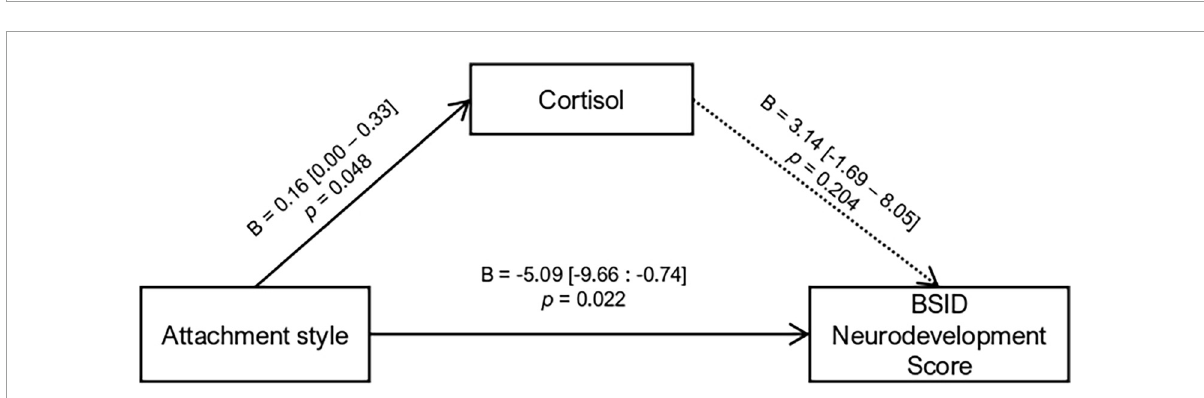
FIGURE3 Mediation analysis for Attachment Style effects on child neurodevelopment via cortisol AUC g . Total effects: B = –4.58 [–8.66: –0.30], p = 0.032; indirect effects: B = 0.52 [–0.12: 2.40], p = 0.365. Values inside brackets indicate 95% bootstrapped confidence